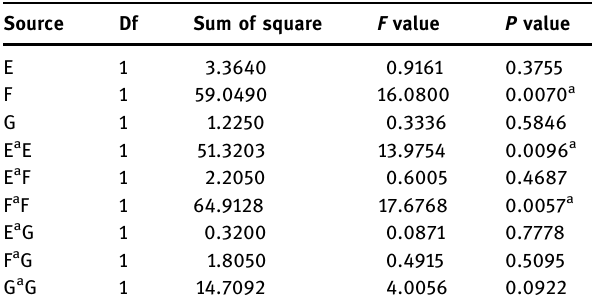
Table 6: Signi fi cance test for the regression coe ffi cients